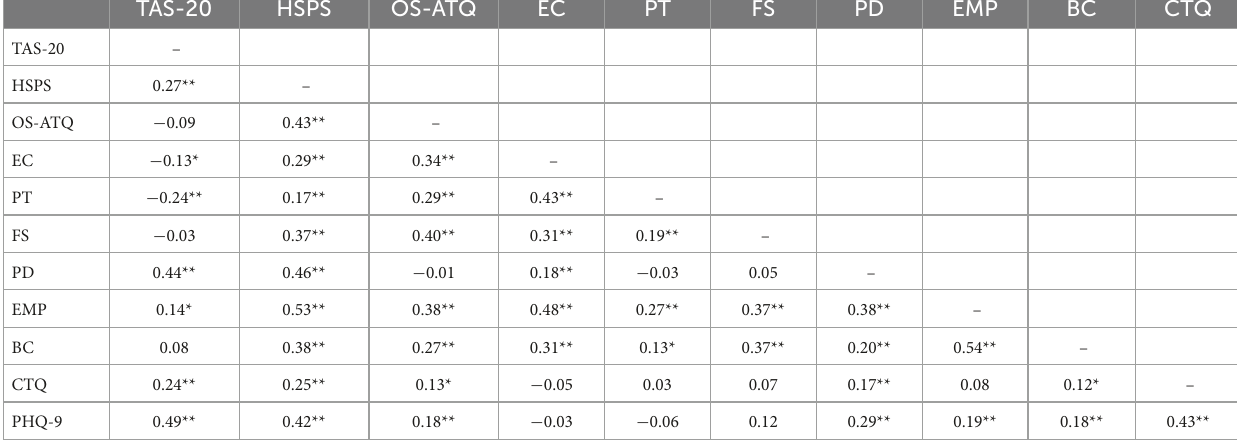
TABLE 1 Pearson correlation coefficients measuring the relationships between the study measures.